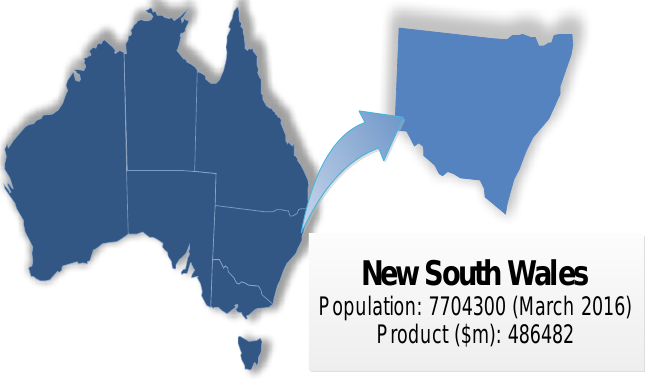
Figure 3. The study area location.